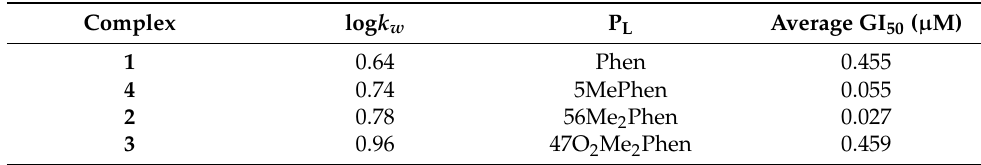
Table 1. The log k w and average GI 50 of each complex, with its corresponding P L . Average GI 50 values were calculated from the panel of cancer cell lines tested (Table S4).